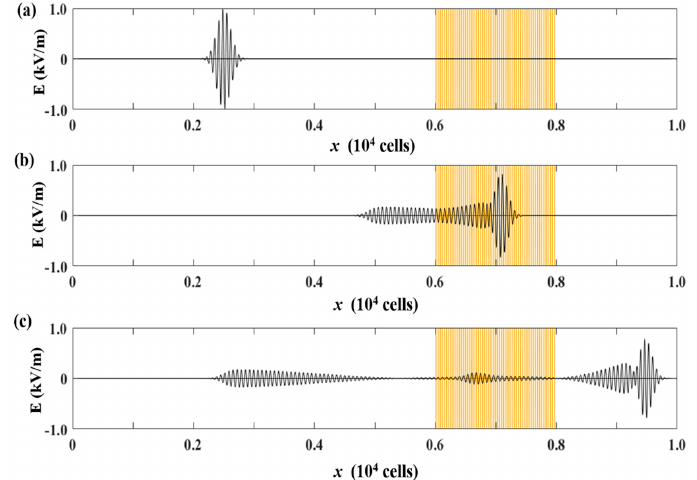
Figure 10. Simulation of a wave propagating in air and striking 1D plasma PhCs with plasma layer thickness d = 20 nm. The plasma has the properties of silver: ω p = 2000 THz, ϑ c = 50 THz. The propagating wave has a center frequency of 4000 THz. ( a , b ) show electric field in the computational domain at different times ( a ) = 0 fs, ( b ) = 15 fs, and ( c ) = 23 fs. (Left side with film thickness of 1000 cells, right side with film thickness of 2000 cells).